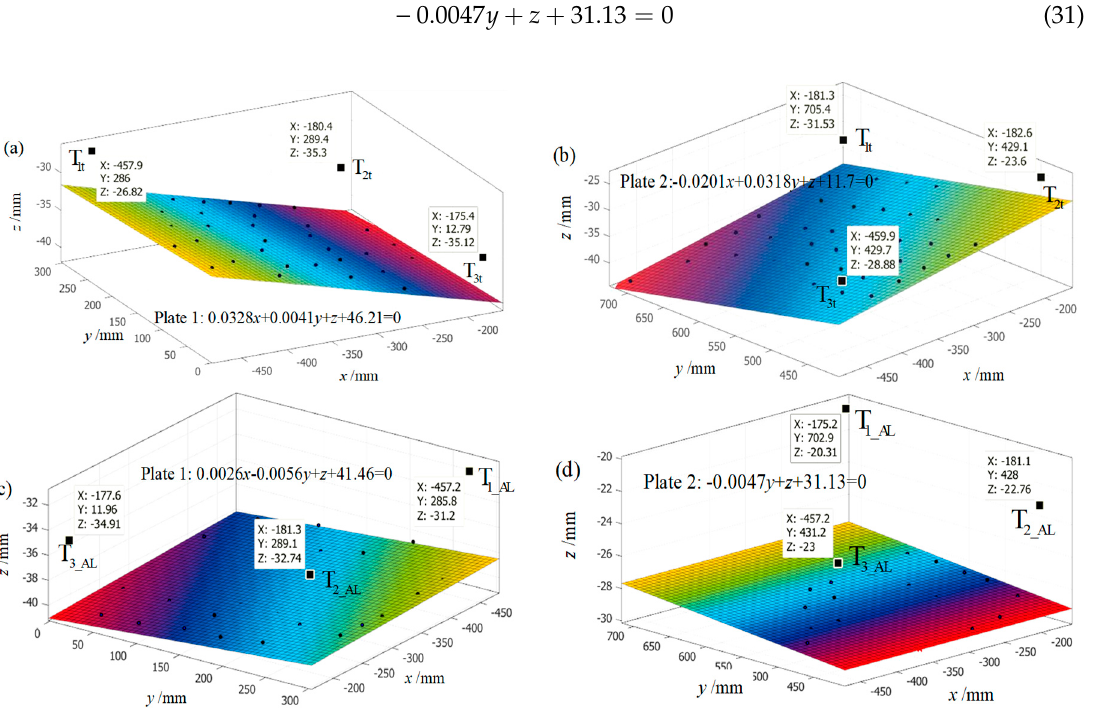
Figure 10. The fitted equation of metal plane (Plate 1 and 2) before and after the adjustment using the three-rotation alignment method: ( a , b ) before adjustment, ( c , d ) after adjustment.